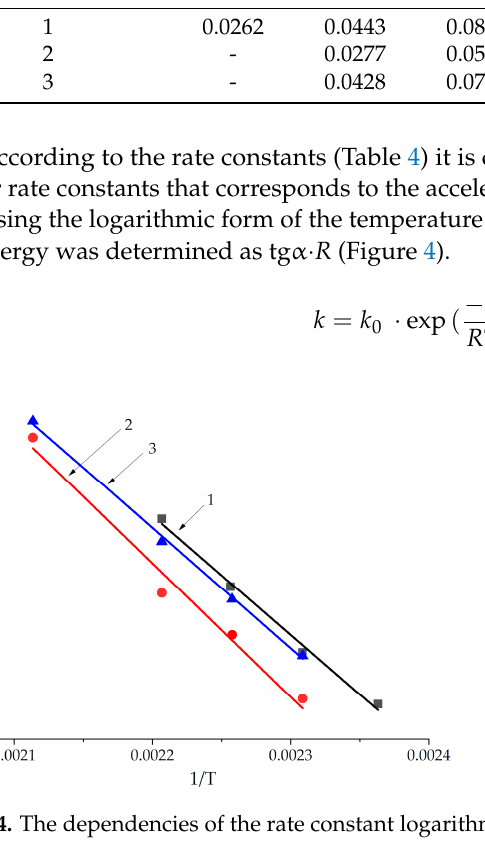
Figure 3. A graphical representation of the curing process in coordinates of the 2-order kinetic equation for formulation 2 of the isotherm of 180 °C, where the red line is the linear fitting and black square is experimental data. Table 4. The values of the rate constants (k 2ord ) and activation energies (E 2ord ) according to the 2-order equation for formulations 1–3.